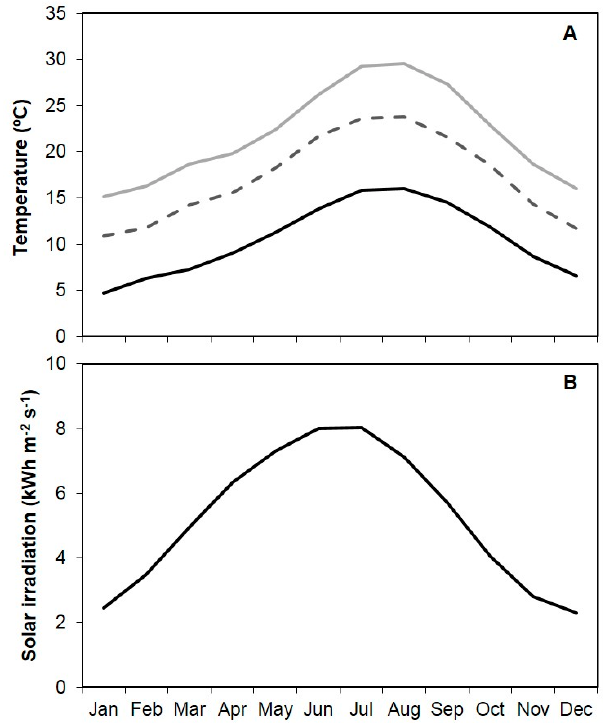
Figure 1. Minimum (black line), maximum (grey line) and average (dashed line) temperature ( A ) and horizontal solar irradiation ( B ) per month observed in Sines municipality, Portugal [32,34].